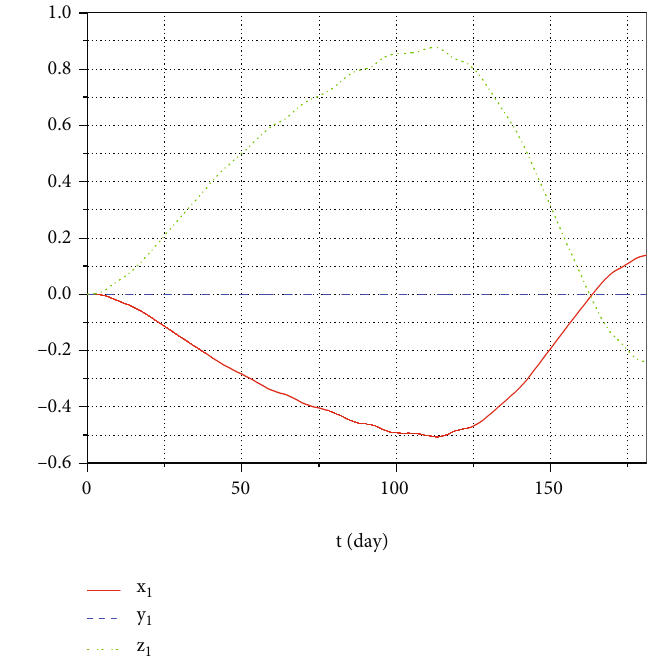
Figure 6: The movement of TM2 relative to the cavity center.